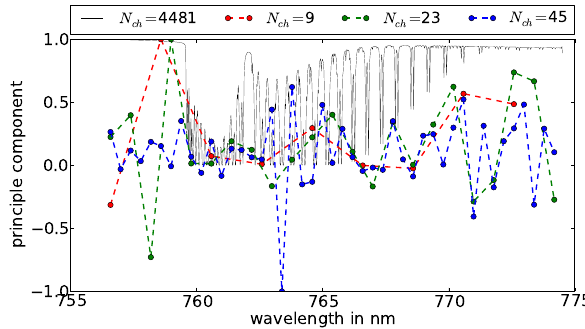
Fig. 6. The grey line shows the first principal component for the complete spectral resolution ( P 0 , − ) while the colored lines show the corresponding rows for ˜ P for three sample sizes. The equal distribution sampling technique was used.